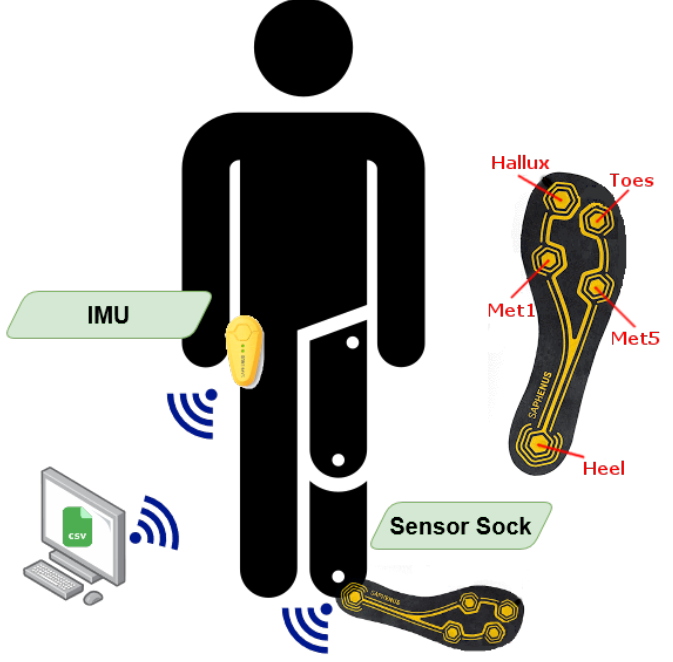
Figure 2. Suralis sensor setup for data acquisition with FSR sensor positions in the sensor